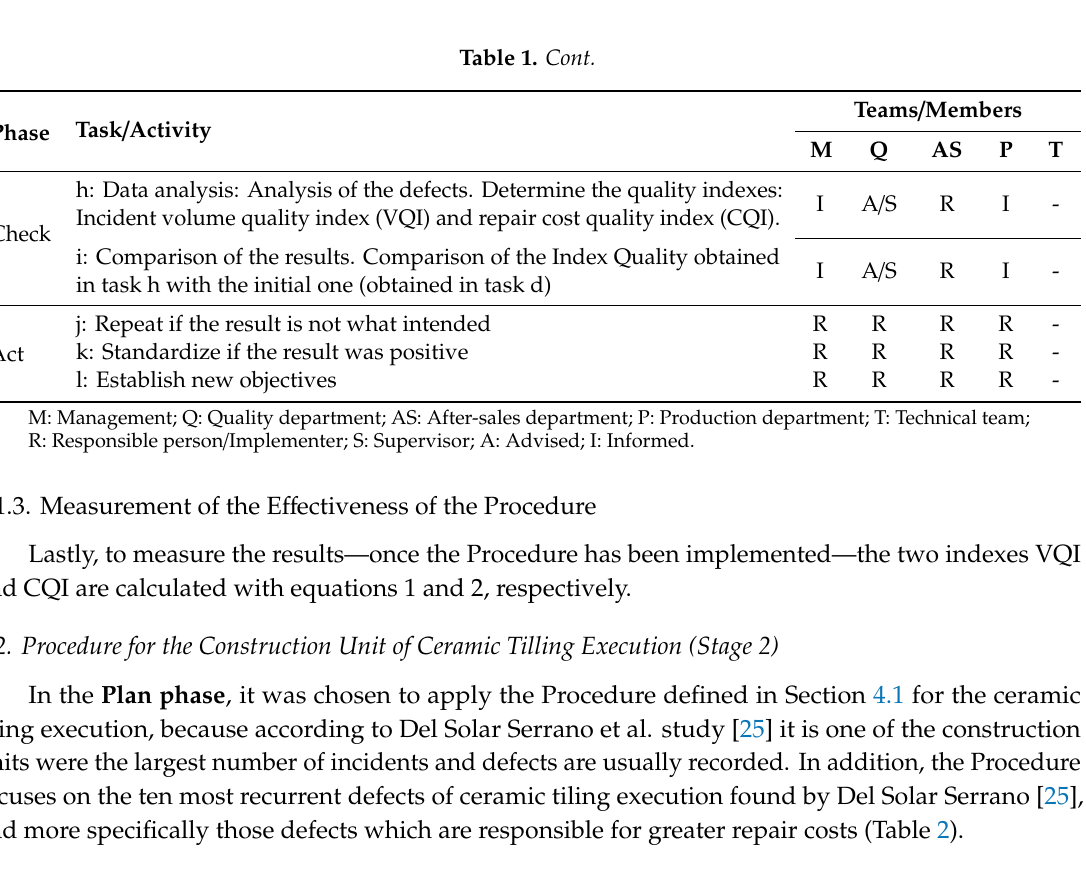
Table 2. Quality indexes of reference given by the construction company (data from [25]). Common Defects in Ceramic Tiling